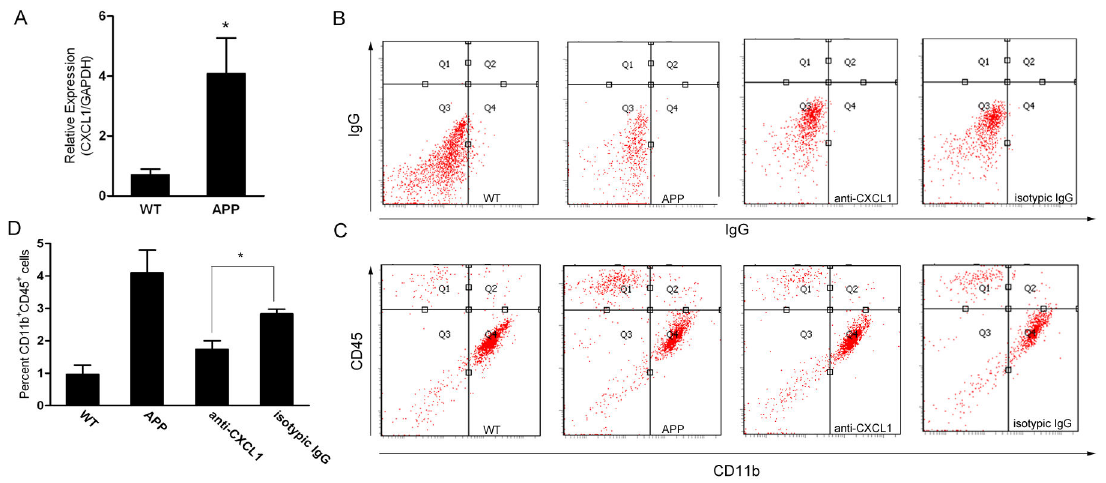
Figure 3. Flow cytometry analysis of microglial accumulation in APP mouse. (A) Monocytes of APP/PS1 tansgenetic mouse and wild type controls were isolated and total RNA was extracted. Real-time RT-PCR was described in Material and Methods. CXCL1/GAPDH means the relative expression level of CXCL1 after correction for the expression of GAPDH. Data was the mean ± S.D. * p < 0.05. (B) and (C) representative dot plots for flow cytometry of CD11b and CD45 stained brain cells. (D) Quantitation of the percent of total brain cells positive for both CD11b and CD45 (CD11b + CD45 + ) by flow cytometry (n = 3 mice per group, * p <